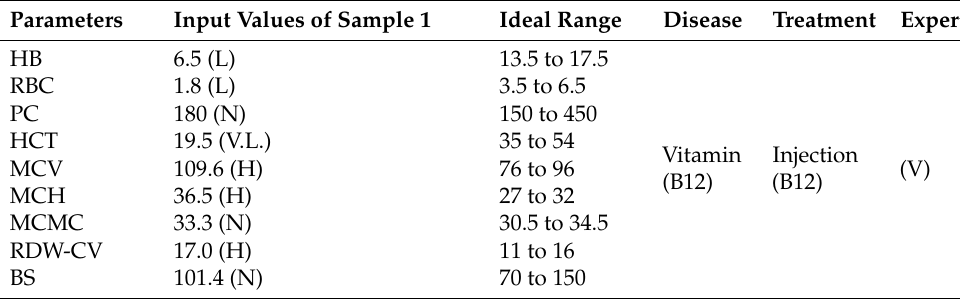
Table 3. Sample 1 and its outcome.